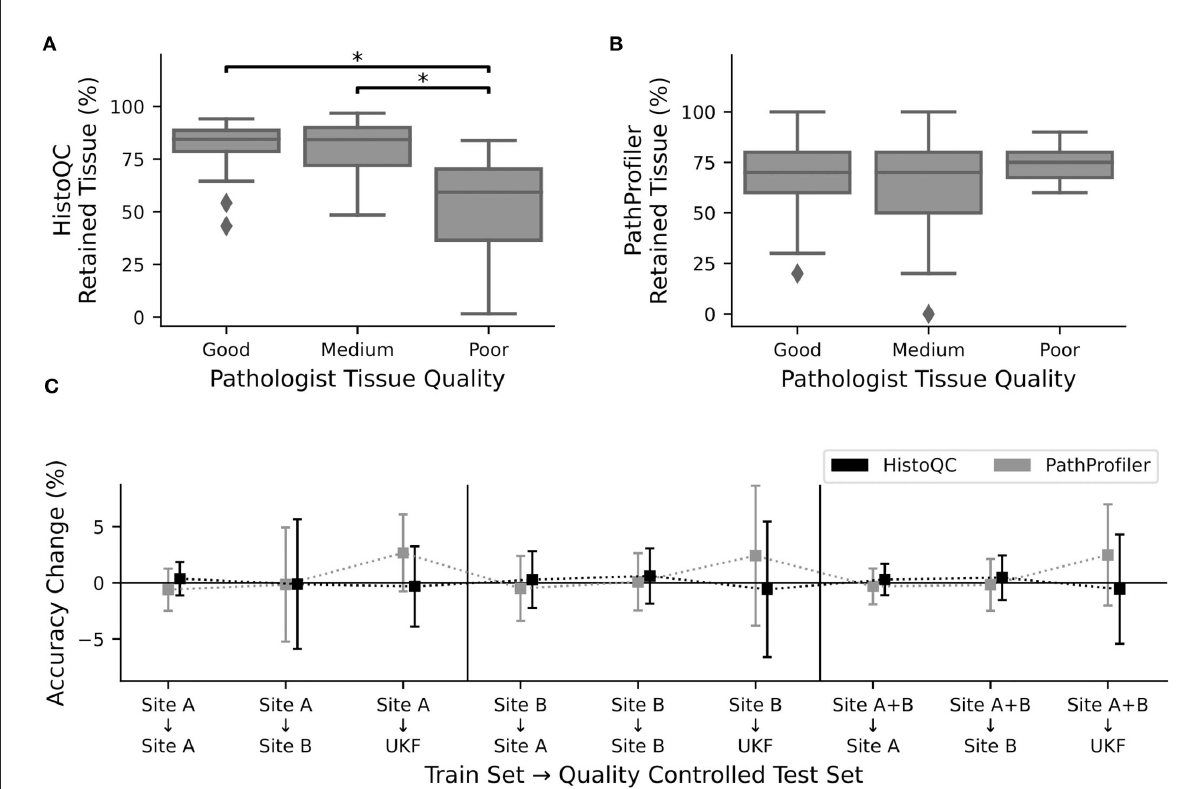
FIGURE3 Quality control tools did not increase performance. Percentage of retained tissue per WSI by (A) . HistoQC and (B) . PathProfiler for the three different quality levels as assigned by pathologist one. For HistoQC, at least one group differs (ANOVA, p -value: 0.00003; post-hoc t -test with Bonferroni Holm p -value adjustments, p < 0.05 are marked with *), and for PathProfiler, there are no significant differences between groups (ANOVA, p -value: 0.34). (C) CNNs trained for Figure 2 were used to calculate the performance on the test datasets, which were now quality controlled by either HistoQC (black) or PathProfiler (light gray) and do not contain tiles of low quality. Plotted is the performance difference between the original and quality-controlled test datasets. Error bars depict standard